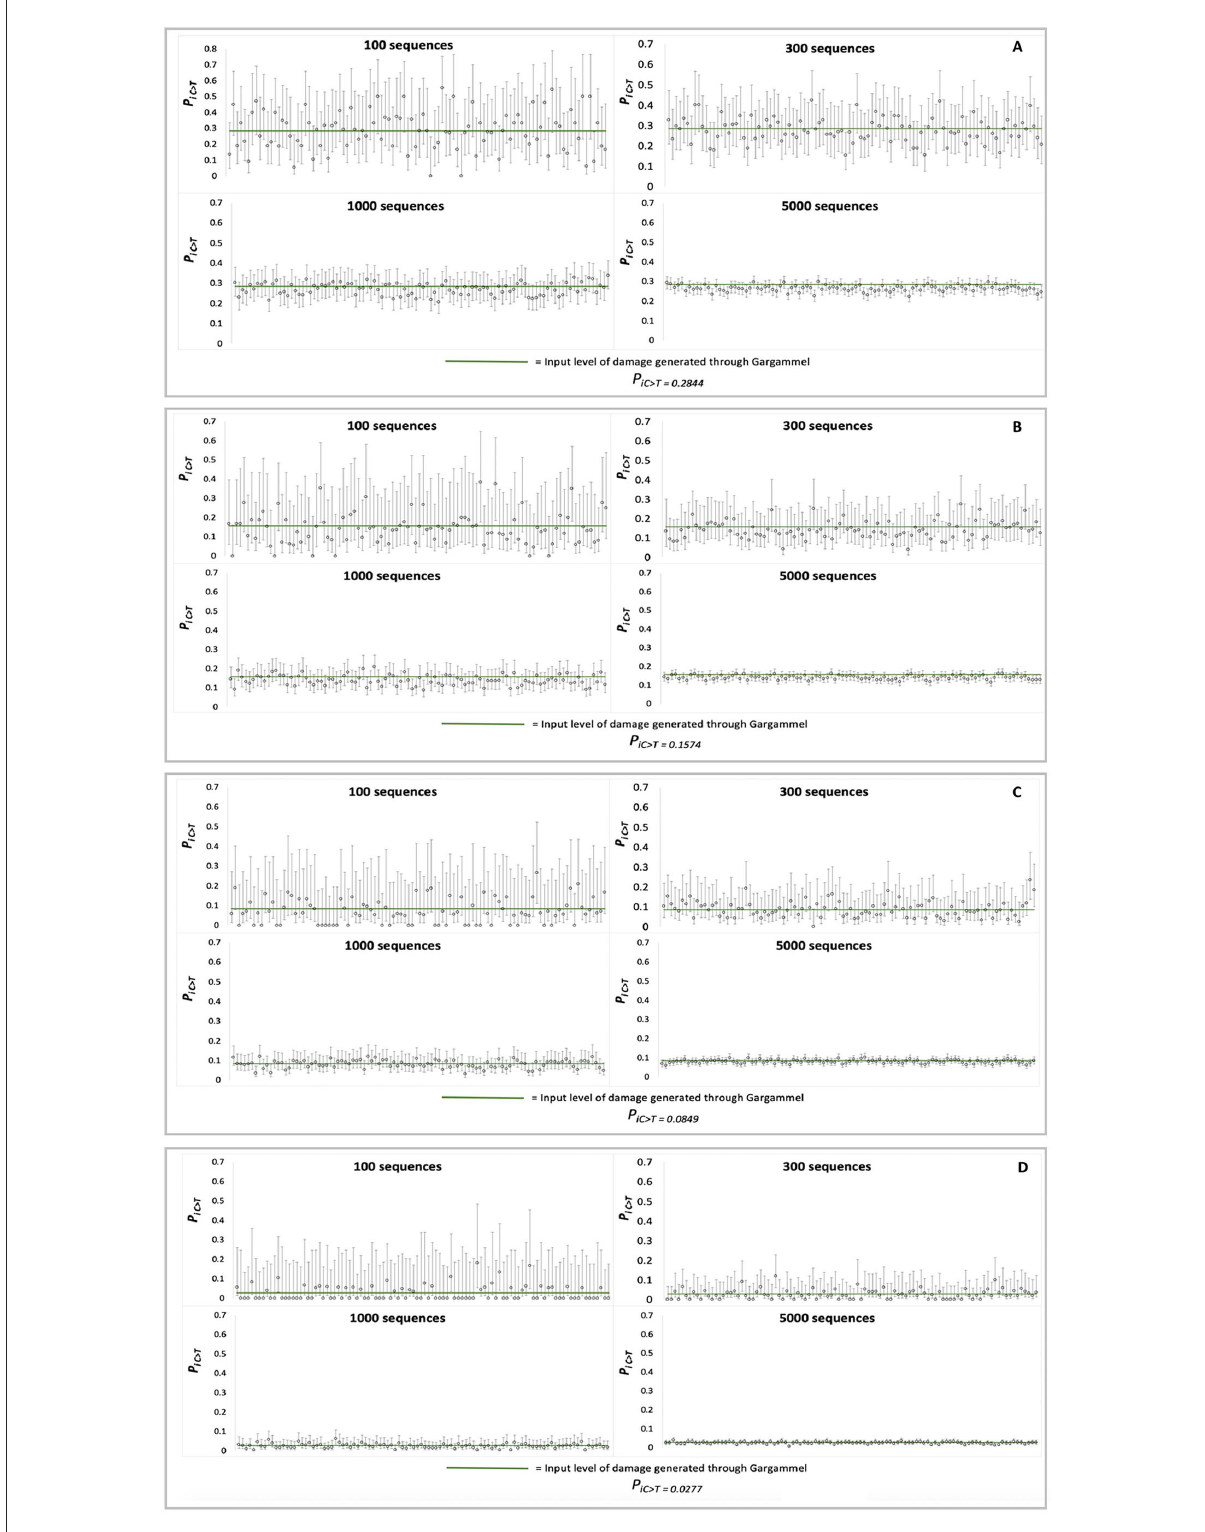
FIGURE3 Observed credible intervals observed in each FASTA input of simulation data ( N = 100 for each plot): (A) RISE145, (B) RISE00, (C) SRR1187907, and (D)